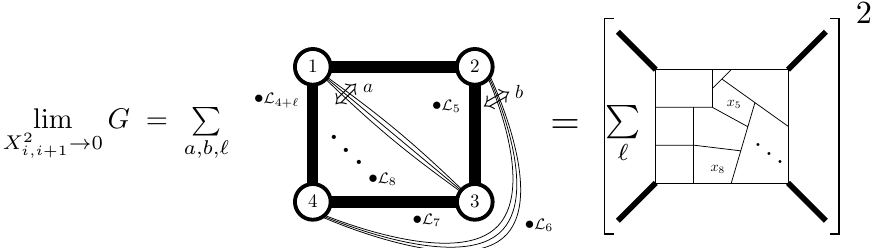
Figure 6 . Extended correlator-amplitude duality: the generating function of all simplest correlators, obtained as the 10D null limit of G , is equal to the square of a four-point amplitude of massive particles in the Coulomb branch of N = 4 SYM. On the left we sum over all diagonal bridges a and b and Lagrangian insertions; their coordinates x become region momenta on the right. The thick lines in the square perimeter represent the infinite R -charge. On the right the thick lines at the corners represent the four massive external particles and the thin lines are massless internal